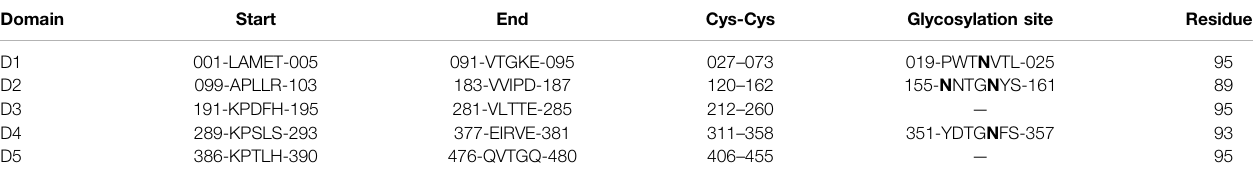
TABLE 2 | Extension and main characteristics of the immunoglobulin-like domains of DM64.